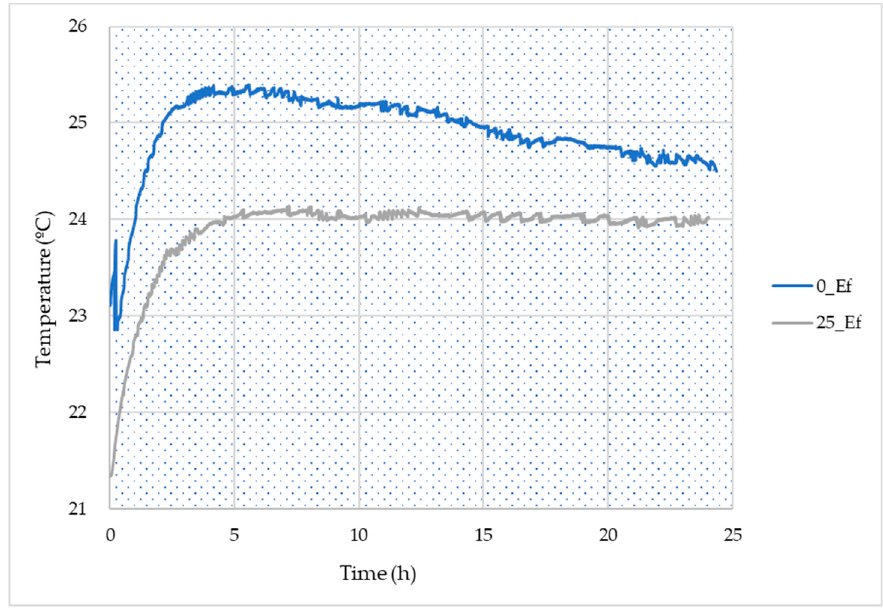
Figure 5. Temperature evolution upon curing measured for the reference and the 25_Ef formulations.